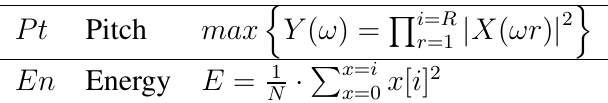
. P , the pitch range is calculated using the HPS (harmonic s t